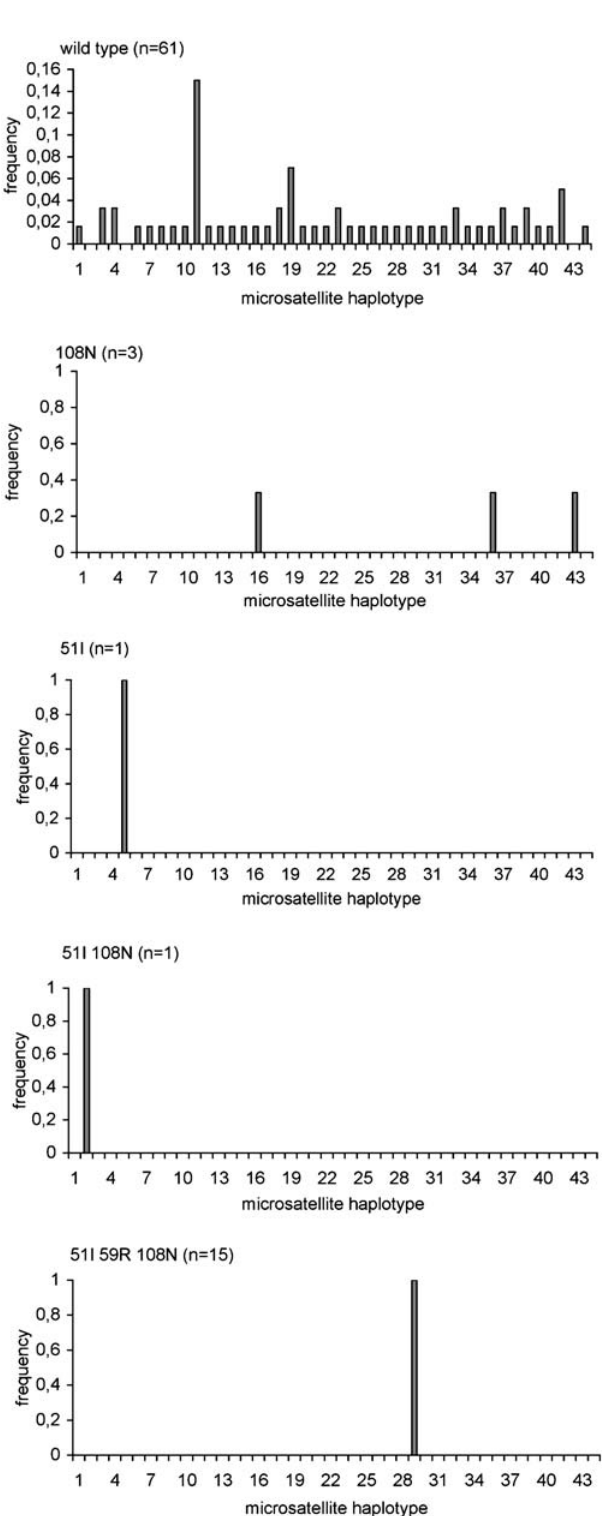
Figure 5. Frequency distribution of Pfdhfr-ts 2 4.4 kb/ 2 01 kb + 0.5 kbmicrosatellite haplotypes by coding the sequence mutant type. The microsatellites were determined as described in Materials and Methods for 81 isolates. The haplotype codes are listed in Table S3.